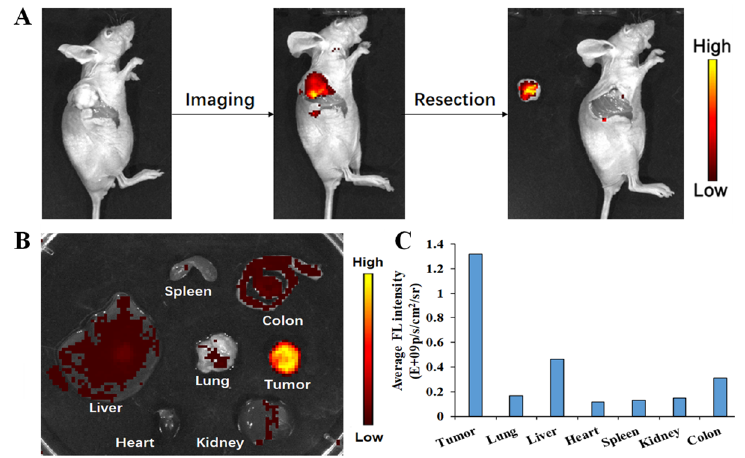
Figure 8. Fluorescence-guided location of tumors in BABL/c mice bearing HeLa xenograft tumors. ( A ) Image-guided resection after intravenous H6M injection in BABL/c mice bearing a HeLa xenograft tumor. ( B ) Ex vivo fluorescence imaging of dissected tumors and main organs of mice at 4 h after injection. ( C ) Quantitative analysis on ex vivo fluorescence imaging.